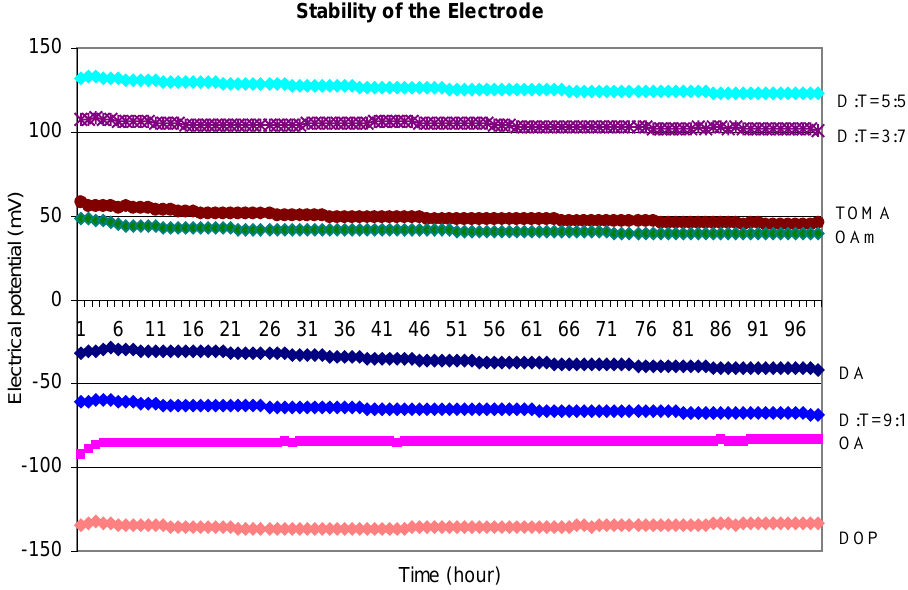
Figure 2. Time course of sensor array response electrical potentials in 1 mM KCl reference